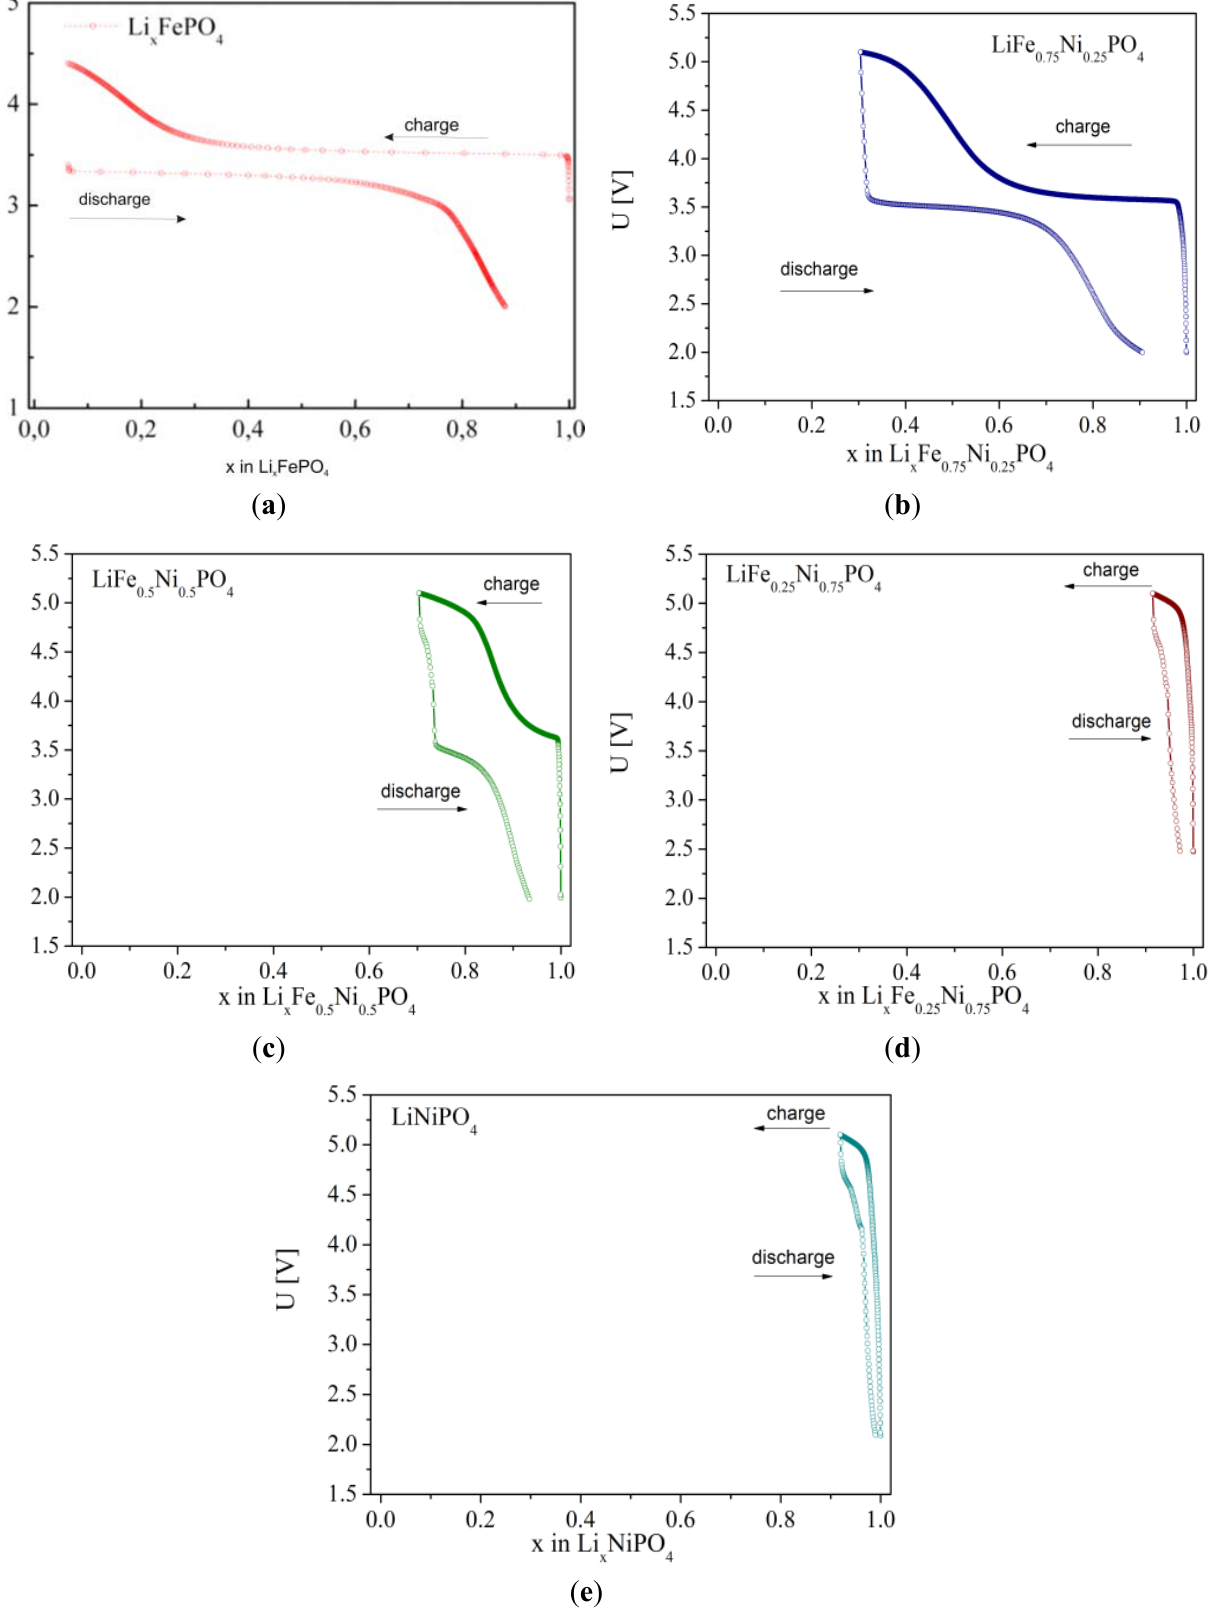
Fe Ni PO cells recorded with C/10 x 1 − y y 4